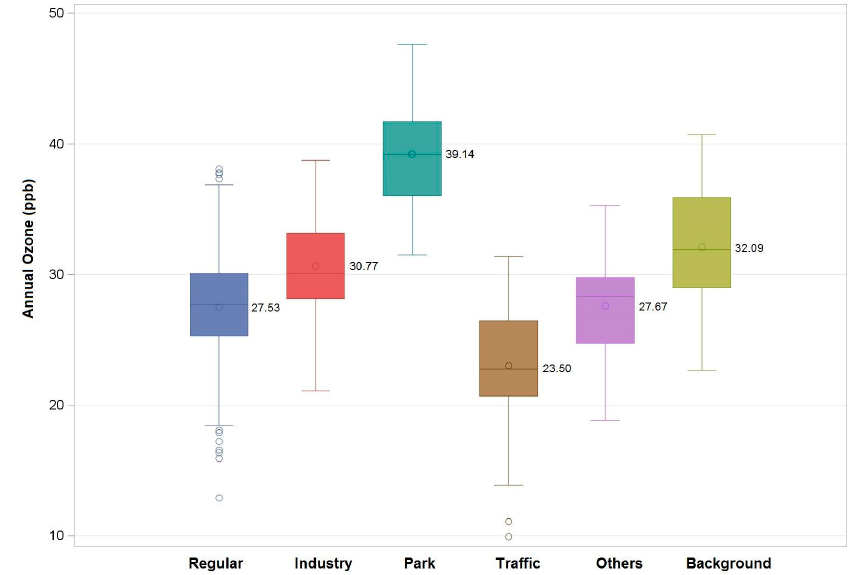
Figure 2. Annual average O 3 levels at six types of monitoring stations over the study years.